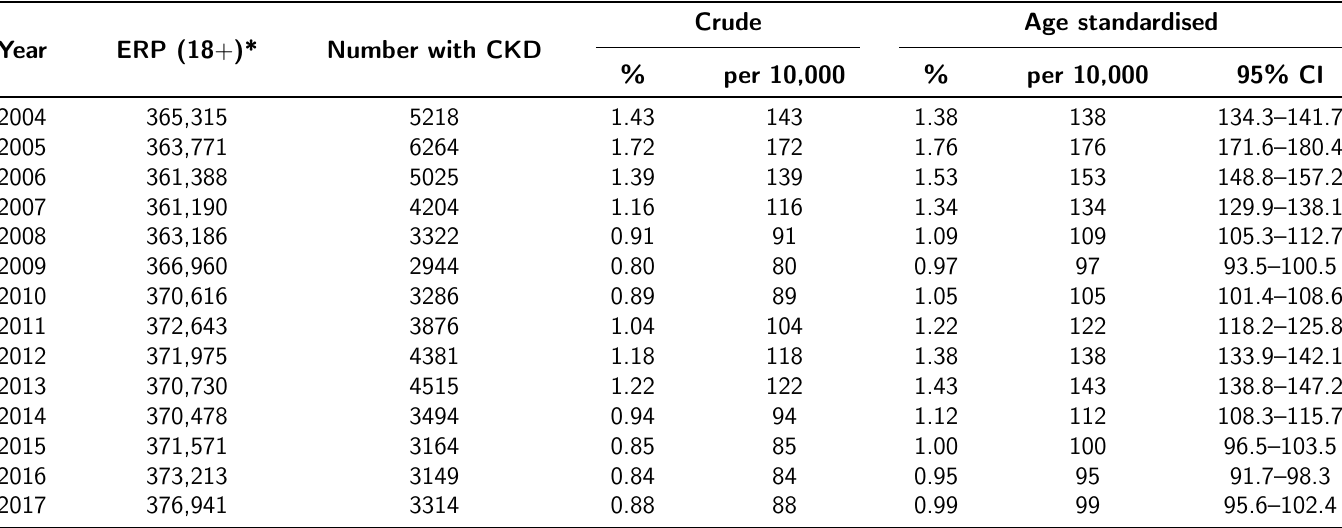
Table 1: Incidence of CKD in Tasmania by calendar year using KDOQI definitions [4]